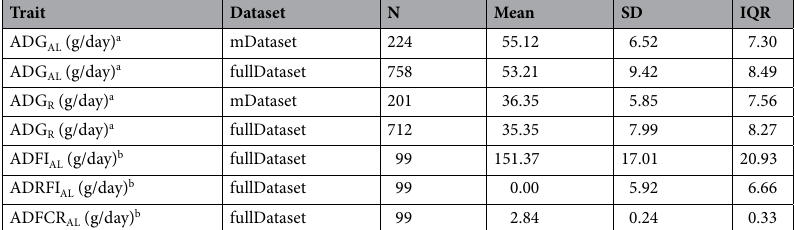
Table 10. Descriptive statistics of growth and FE traits. ADG AL , average daily gain in rabbits fed ad libitum; ADG R , average daily gain in rabbits fed under restriction; ADFI AL , average daily feed intake in rabbits fed ad libitum; ADRFI AL , average daily residual feed intake in rabbits fed ad libitum; ADFCR AL , average daily feed conversion ratio in rabbits fed ad libitum; SD, standard deviation; IQR, interquartile range; mDataset, dataset including only records of animals in which microbiota was assessed; fullDataset, dataset including records of animals in which microbiota was assessed as well as of their cage mates. a Refers to individual traits. b Refers to cage